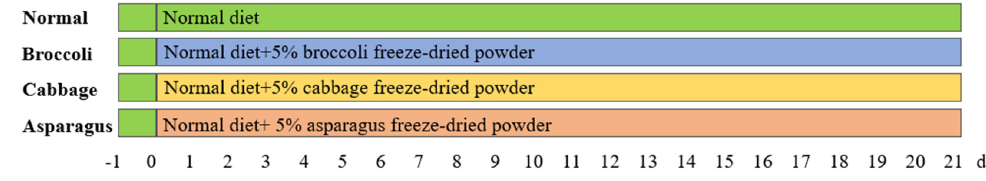
Figure 1. Experimental period diagram.